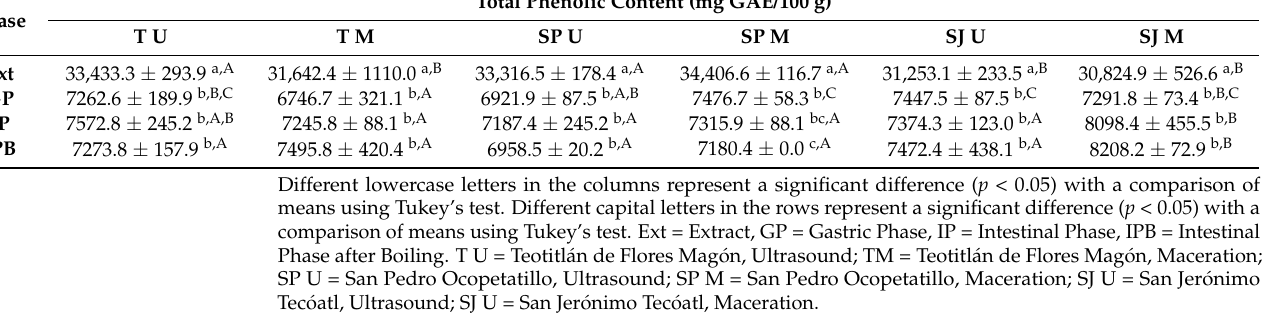
Table 2. Behavior of total phenols during the in vitro digestion of different propolis extracts.